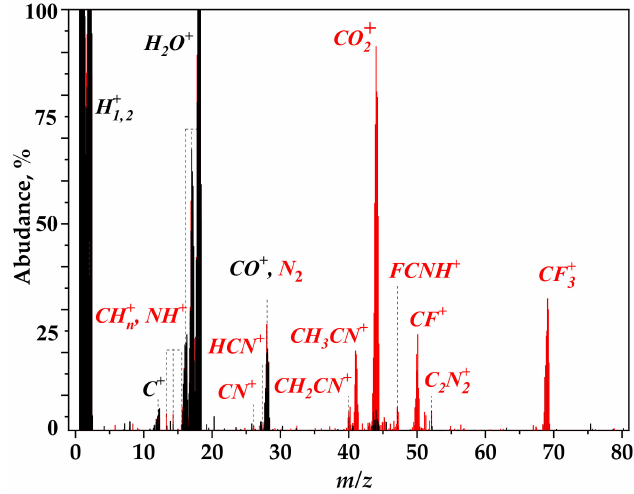
Figure 5. Mass spectrum registered upon white beam irradiation of CH 3 CN@CF 0.3